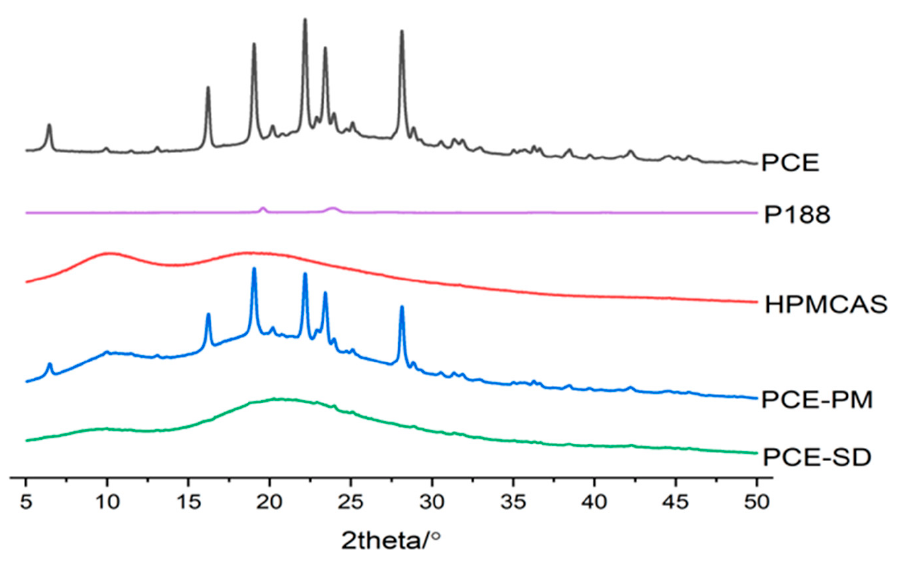
Figure 17. XRD spectrum of PCE, carriers, PM and PCE-SD.